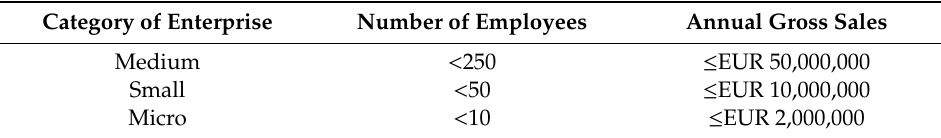
Table 1. Limit values for determining the category of